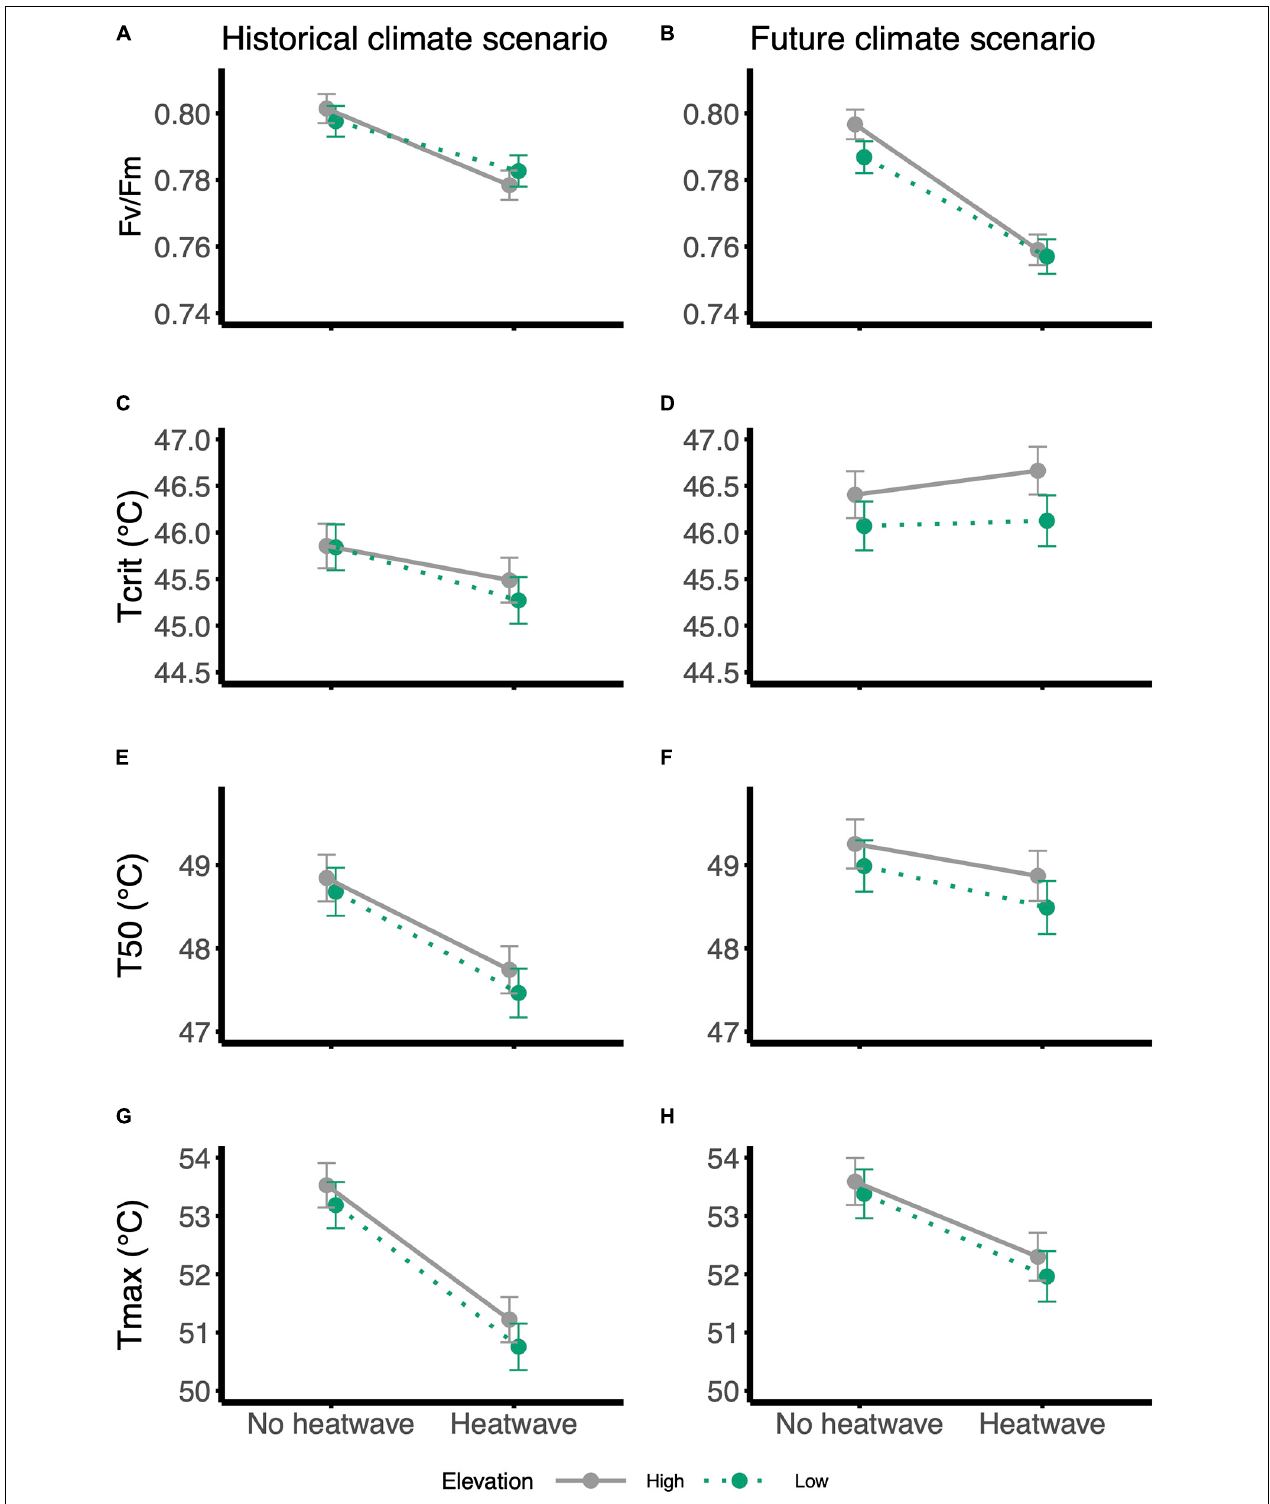
FIGURE 2 | Reaction norms for thermal physiology traits in response to the heatwave treatment: (A,B) F v / F m , (C,D) T crit , (E,F) T 50 and (G,H) T max . Panels on the left: historical climate scenario; panels on the right: future climate scenario. Gray and solid lines = high-elevation families; green and dotted lines = low-elevation families. Values were estimated from the models using the emmeans function in ‘emmeans’ package, in R; error bars are standard errors.